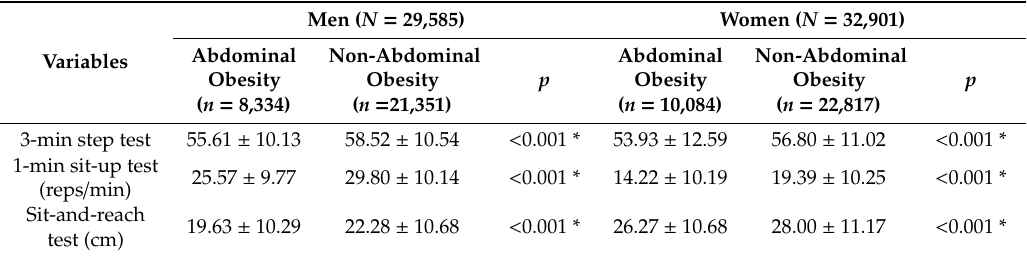
Table 2. Health-related physical fitness measurements based on abdominal obesity status among Taiwanese adults.